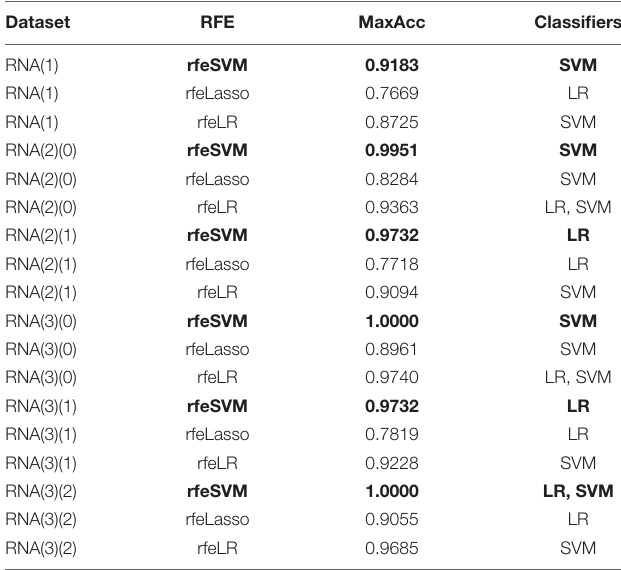
TABLE 3 | Summary of whether each classifier achieved the best classification accuracy on the 19 feature subsets of each dataset. Dataset RFE MaxAcc Classifiers